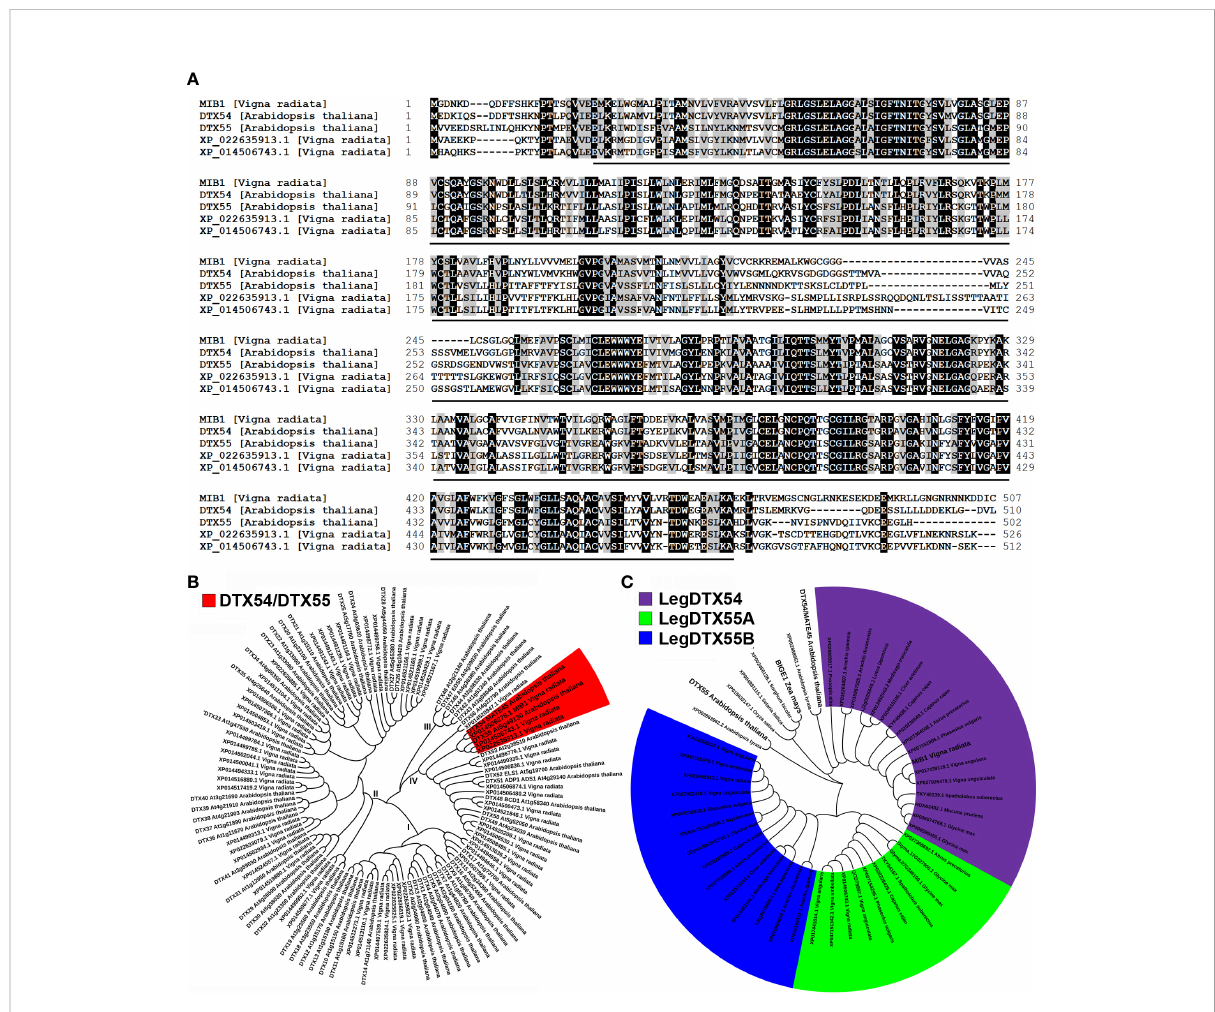
FIGURE 4 Analysis of the MIB1 protein isolated from mungbean. (A) Alignment of amino acid sequences of MIB1, DTX54, DTX55, XP_022635913.1, and XP_014506743.1. The conserved MatE domain was indicated by the black line. (B) Phylogenetic tree of MATE family proteins in mungbean and Arabidopsis . I, II, III, and IV represent four different groups. (C) Phylogenetic analysis of LegDTX54 clade and LegDTX55 clade proteins in